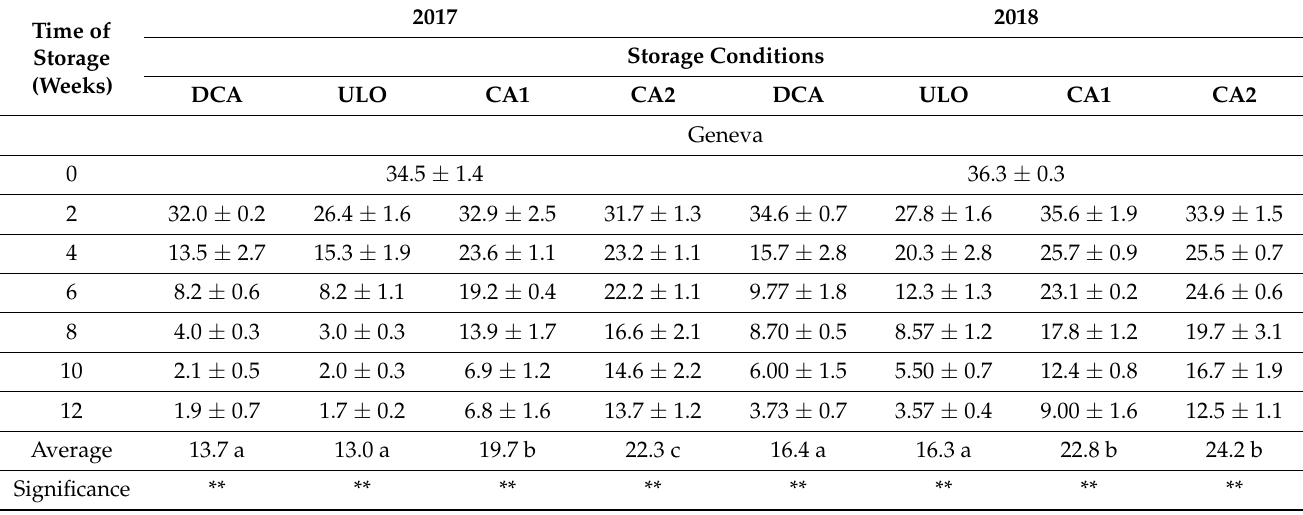
Table 1. Changes in firmness (N) measured in ‘Geneva’ and ‘Ananasnaya’ minikiwi fruit in the postharvest period. Time